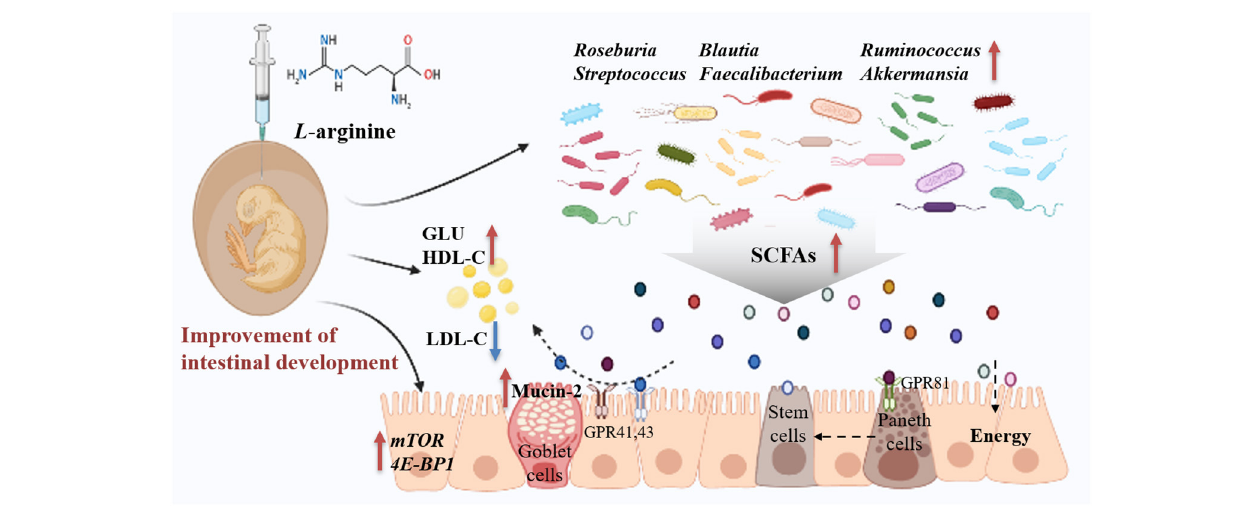
FIGURE 8 | Summary of clarifying how prenatal L -arginine supplementation improves the embryonic intestine development in a chick embryo model. The red up-arrow represents upregulated, whereas the blue down-arrow represents downregulated; GLU, Glucose; GPR, G protein-coupled receptors; HDL-C, High-density lipoprotein cholesterol; LDL-C, Low-density lipoprotein cholesterol; SCFAs, short-chain fatty